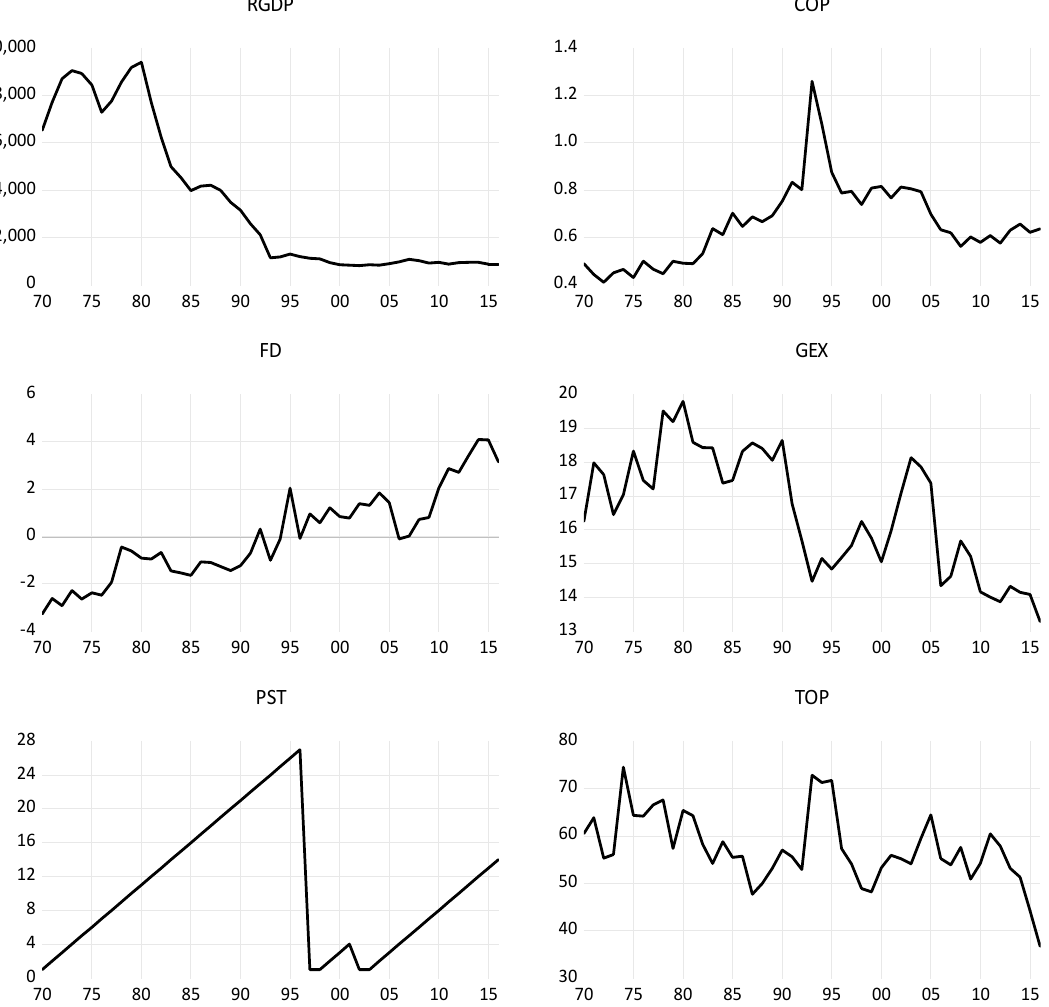
Figure 1. The time series plotting of the estimated series.